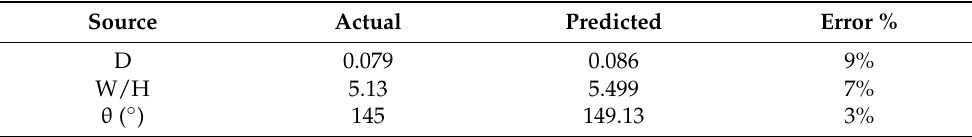
Table 9. Comparison between the predicted optimization results and experimental verification